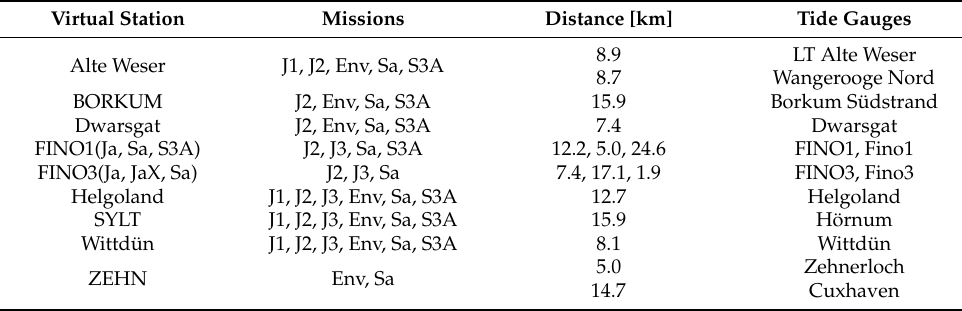
Table 1. Virtual positions, the available missions, collocated tide gauges and the distance between both for Jason-1 (J1), Jason-2 (J2), Jason-3 (J3), Envisat (Env), Saral/AltiKa (Sa) and Sentinel-3A (S3A). FINO platforms are equipped with two gauge sensors (FINO/Fino) with different measurement